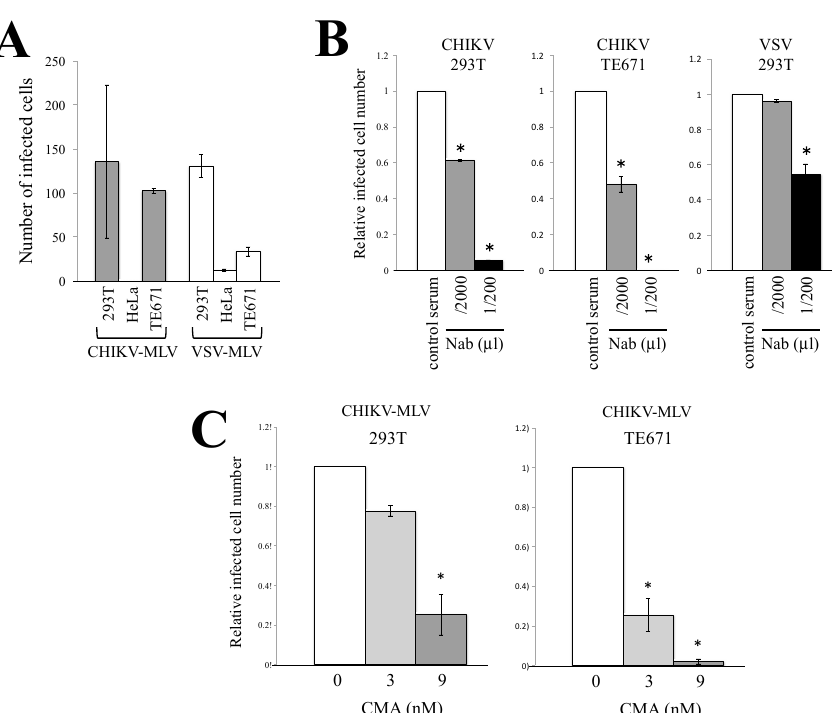
Figure 1. Endosome acidification is required for Chikungunya virus (CHIKV)-pseudotyped murine leukemia virus (MLV) vector infection. ( A ) 293T, HeLa, and TE671 cells were incubated with CHIKV-pseudotyped MLV vector. The cells were stained with X-Gal, and blue cells were counted in eight microscope fields. Total numbers of blue cells are indicated. This experiment was repeated in triplicate, and averages are shown. Error bars indicate standard deviations. ( B ) 293T and TE671 cells were inoculated with CHIKV-pseudotyped MLV vector in the presence of a serum from a CHIKV-infected patient that has neutralization activity, and numbers of blue cells were counted. Blue cell numbers in the presence of the control human serum were always set to 1. Relative values to the blue cell numbers detected in the cells treated with the same volume of dimethyl sulfoxide (DMSO) are indicated. This experiment was repeated in triplicate, and averages are shown. Error bars indicate standard deviations. Asterisks indicate statistically significant di ff erences compared to the values in the presence of the control serum. ( C ) Concanamycin A (CMA)-pretreated 293T or TE671 cells were incubated with CHIKV-pseudotyped MLV vector, and the blue cells were counters after staining with trypan blue. Relative values to the blue cell numbers detected in the cells treated with the same volume of DMSO are indicated. Blue cell numbers in DMSO-treated cells were always set to 1. This experiment was repeated in triplicate, and averages are shown. Error bars indicate standard deviations. Asterisks indicate statistically significant di ff erences compared to the values in DMSO-treated